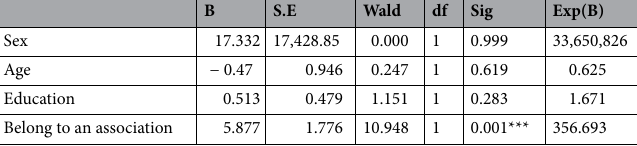
Table 4. Regression of Determinants of Business Registration. ***Significance level at